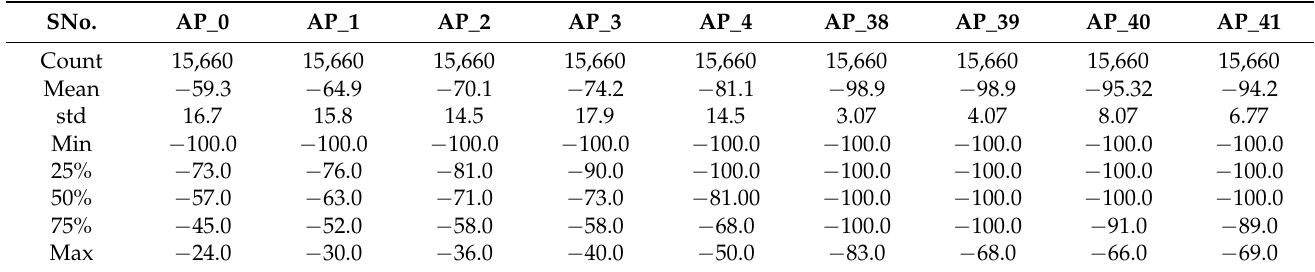
Table 4. The distribution and descriptive measures of the Offline RSS measures.